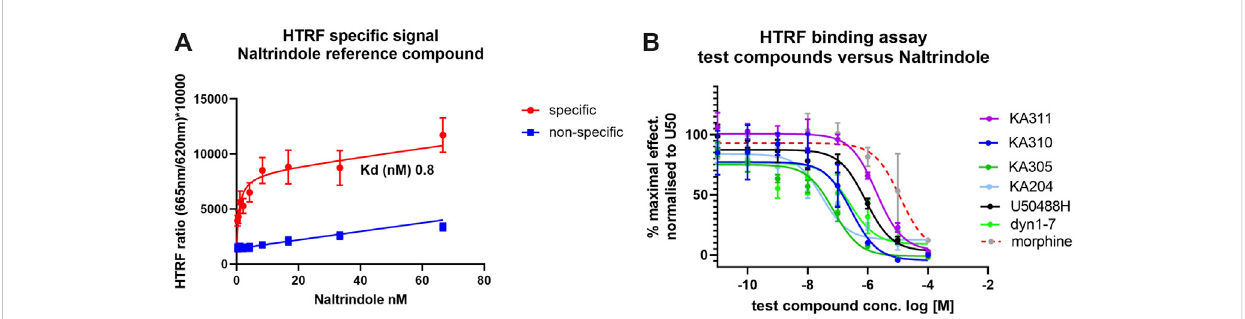
FIGURE 5 Binding af fi nity of test ligands to KOP receptor in a HTRF assay. (A) speci fi c (red) and non-speci fi c (blue) binding of tagged naltrindole to the KOP- expressing cells. The saturation binding coef fi cient (K d ) was calculated for the reference ligand was calculated at 0.8 nM. (B) Completive binding assay data of test and control compounds versus the reference ligand (at approx. K d.80 ; 8 nM, as recommended by the manufacturer) in the HTRF assay. The